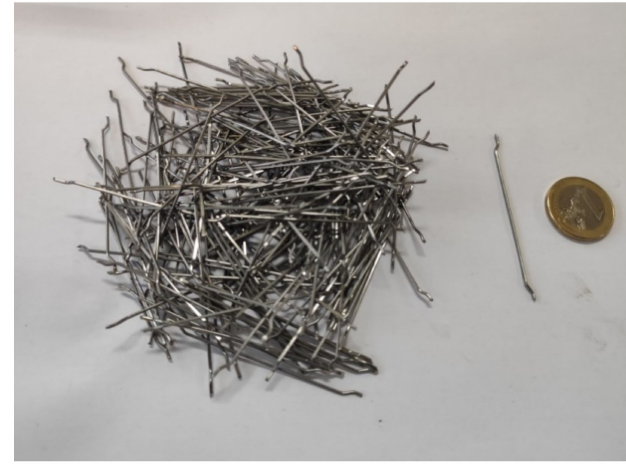
Figure 2. Hooked-end steel fibres